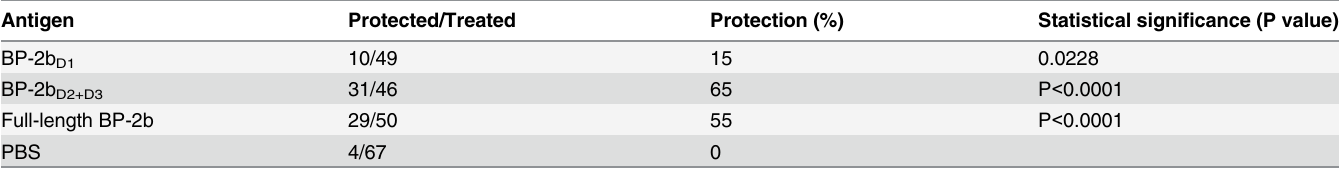
Table 3. Neonatal protection conferred by BP-2b domains vs the full length protein against GBS strain COH1 assessed by active maternal mouse immunization/neonatal pup challenge model.